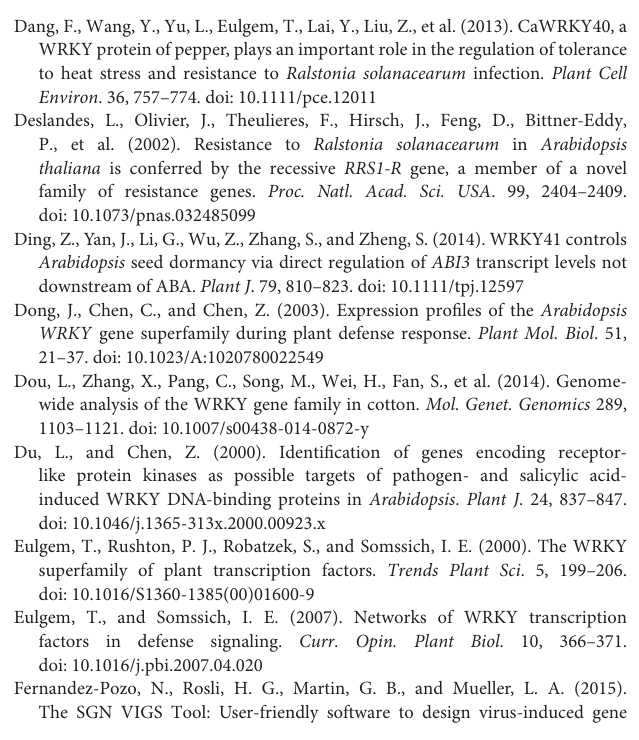
Supplementary Figure 1 | Distribution of MeWRKY genes on cassava chromosomes. Vertical bars represent chromosomes. Base-pair positions are indicated on the left. Supplementary Figure 2 | Unrooted phylogenetic tree of WRKY proteins from cassava and Arabidopsis. The NJ tree was constructed using MEGA 7.0 with 1,000 bootstraps.